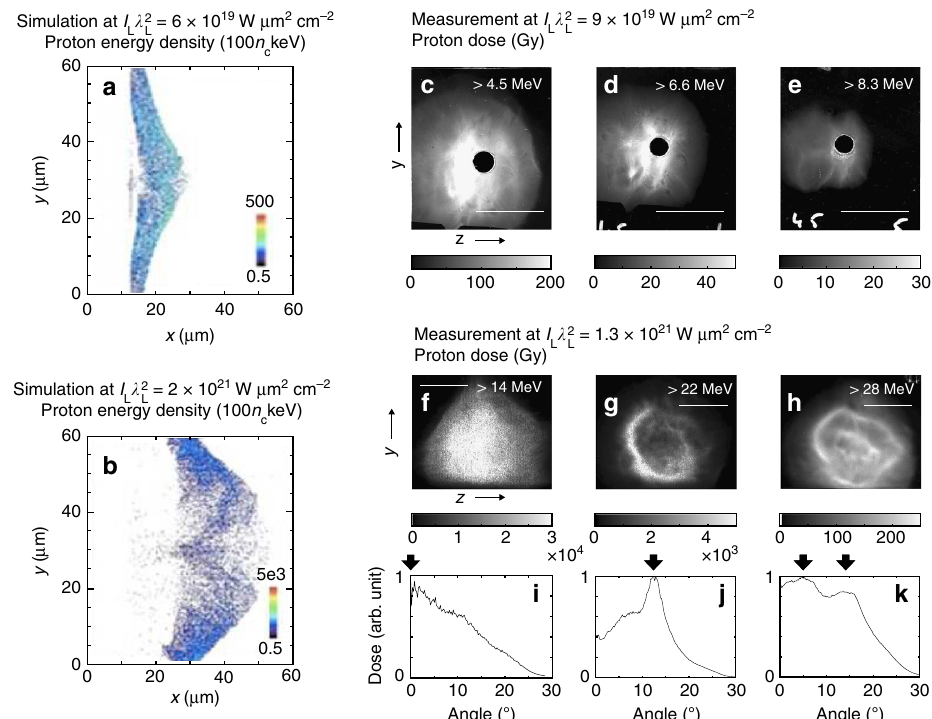
Fig. 4 Magnetic de fl ections of protons at high laser intensity. a , b Maps of the proton energy density (in units of 100 n c keV, where n c = 1.1 × 10 21 cm − 3 is the critical density at 1 μ m wavelength) as recorded, at the time of the laser peak, from the 2D PICLS simulations illustrated in Fig. 1a and e, respectively. b clearly reveals that at high laser intensity, the protons at the acceleration front are de fl ected by the magnetic fi eld, forming a ring-like pattern. c – h Experimental 2D proton dose distributions (in Gy) measured using stacks of calibrated radiochromic fi lms. In c – e , the laser parameters are I λ 2 ¼ 9 ´ 10 19 W μ m 2 cm (cid:1) 2 , λ = 0.5 μ m, ϕ = 0.9 μ m, τ = 400fs, and the target consists of a 0.5 μ m thick Al foil. In f – h , the laser parameters are L L L L L λ 2 ¼ 1 : 3 ´ 10 21 W μ m 2 cm (cid:1) 2 , λ = 1 μ m, ϕ = 1.5 μ m, τ = 800 fs, and the target is a 1.1 μ m thick Au foil, yielding a ring-like pattern on the proton dose I L L L L L distribution, consistent with the simulation shown in b . For the > 28 MeV protons, this ring pattern encircles what looks like a central jet, which may result from some high-energy protons emitted on axis and having experienced relatively weak de fl ections. The white bars in c – h indicate an angular spread of 20°. i – k Proton dose vs. angle with respect to the target-rear normal, as extracted from the proton distribution displayed in f – h , respectively. Arrows indicate the angular